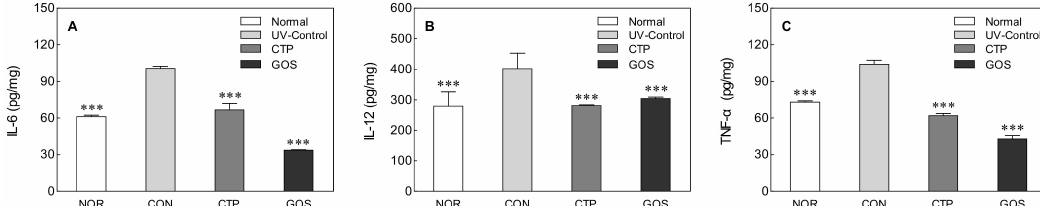
Figure 4. E ff ect of galacto-oligosaccharide (GOS) intake on interleukin (IL)-6 ( A ), IL-12 ( B ), and tumor necrosis factor- α (TNF- α , C ) levels in ultraviolet (UV) B-irradiated hairless mice. Data are expressed as mean ± standard deviation, and di ff erent symbols indicate significant di ff erences at *** p < 0.001 vs. CON group. Normal (NOR; unirradiated mice); ultraviolet (UV) B control (CON; irradiated and untreated mice); CTP intake at 200 mg / kg (CTP; irradiated and CTP-treated mice); GOS intake